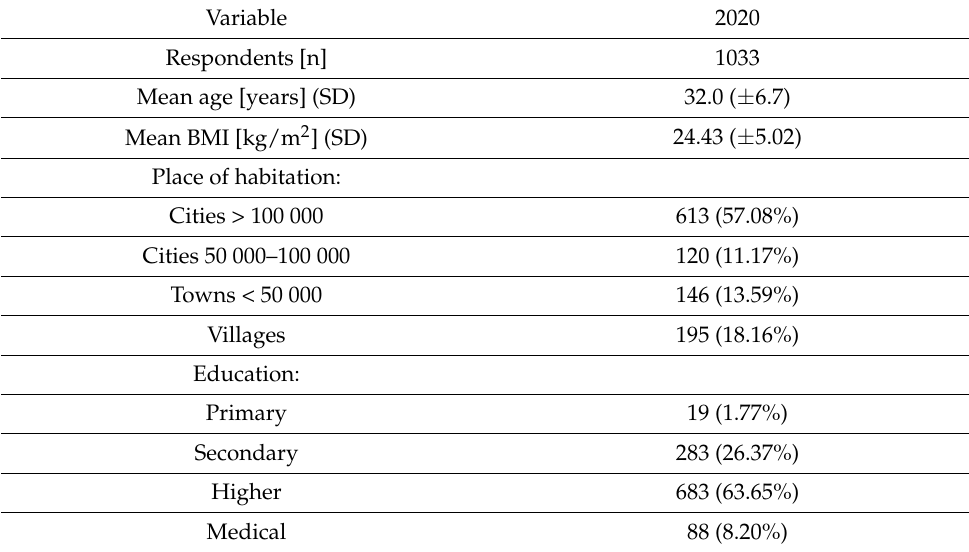
Table 1. Baseline characteristics of the study